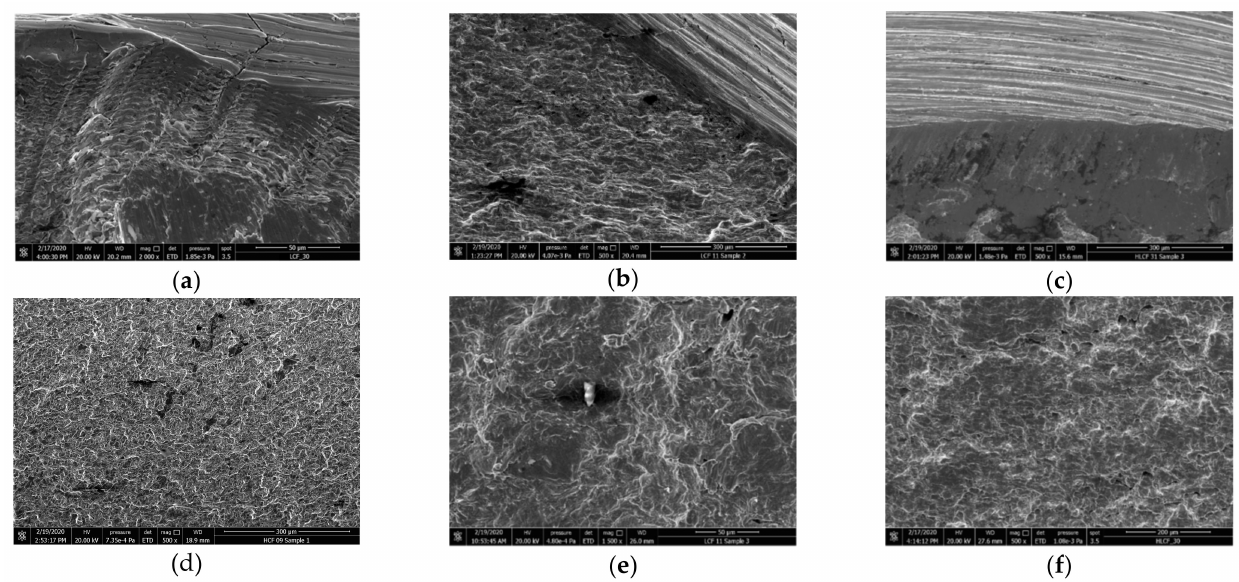
Figure 6. Microfractographs of the fracture surfaces: ( a ) HCF fracture near the surface; ( b ) LCF fracture near the surface; ( c ) HLCF fracture near the surface; ( d ) HCF fracture surface in the crack propagation area; ( e ) LCF fracture surface in the crack propagation area; ( f ) HLCF fracture surface in the crack propagation area.